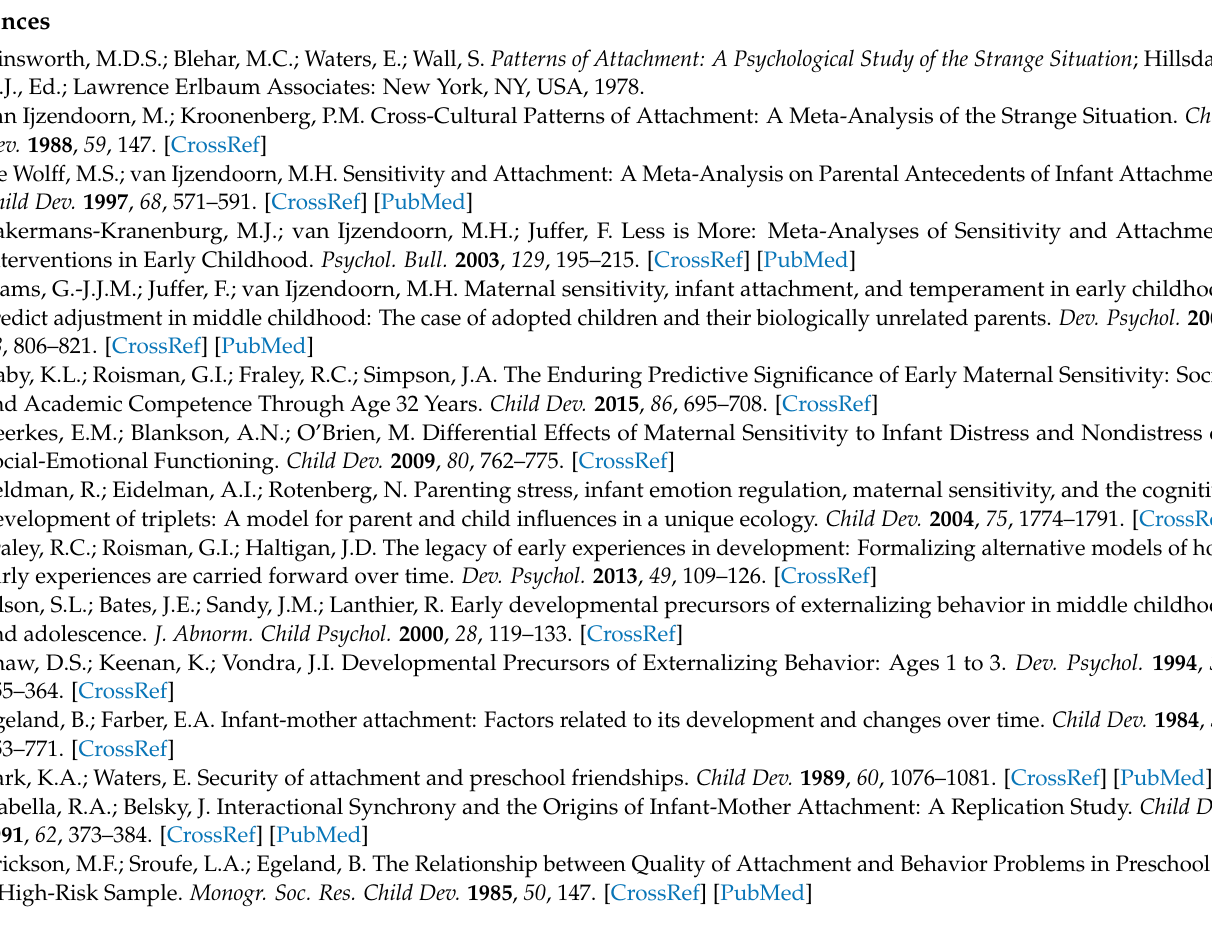
Table S1: Maternal styles correlations with all significant electrode